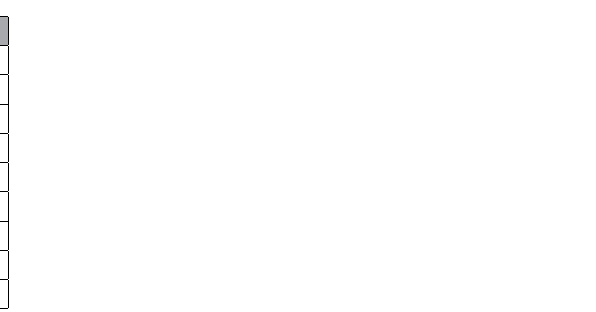
Table 2. The evaluation results (including IoU, DSC, and accuracy) of models trained by varying α for CE loss ( γ = 0, dropout rate